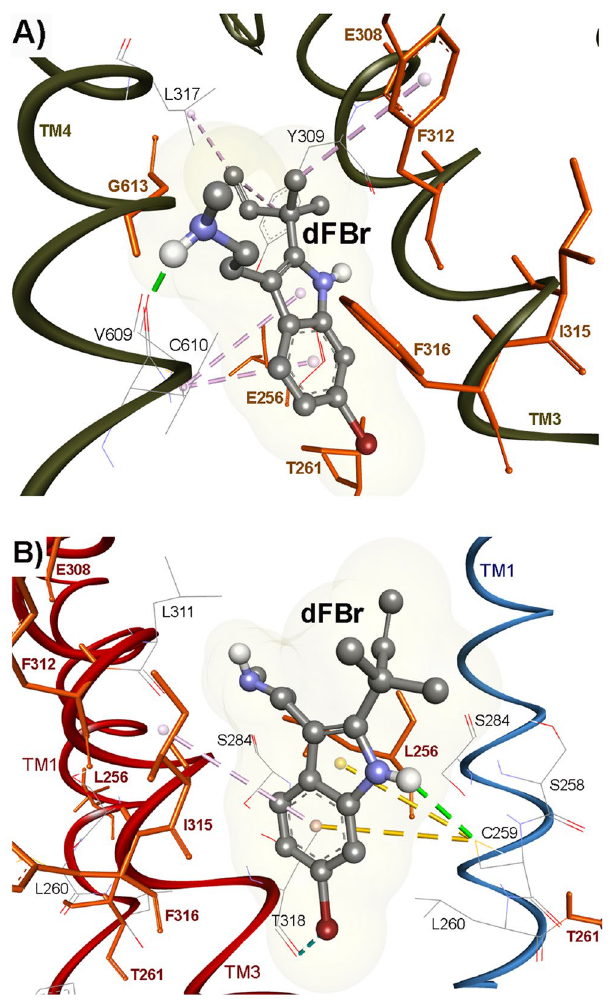
Figure 11. dFBr binding sites in the transmembrane domain of ( α 4)3( β 2)2 nAChR. Side views showing dFBr docked within the α 4 subunit transmembrane helix bundle (Binding Site 1, A ) and at the α 4: α 4 transmembrane interface (Binding Site 3, B ). The α 4 subunits are shown as ribbon with the subunit that provides the ( + )face and ( − )face of the α 4: α 4 interface are colored in red and cyan, respectively. dFBr is shown in ball and stick format colored by element whereas key amino acids side chains are shown in line format. Hydrogen bond interactions and non-bond hydrophobic interactions between dFBr and amino acids residues within Binding Site 1 and 3 are shown as green and violet dashed lines,